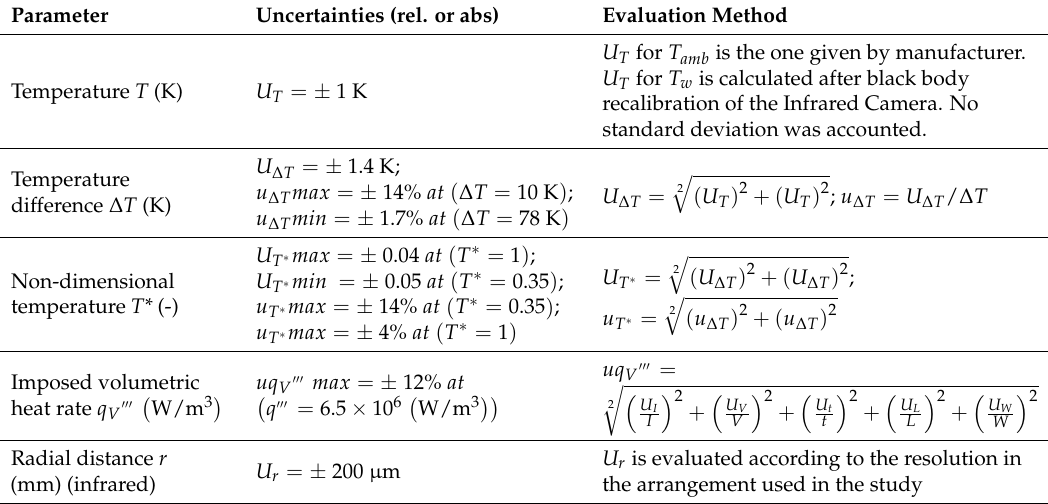
Table 1. Uncertainties of the measured parameters used for heat transfer